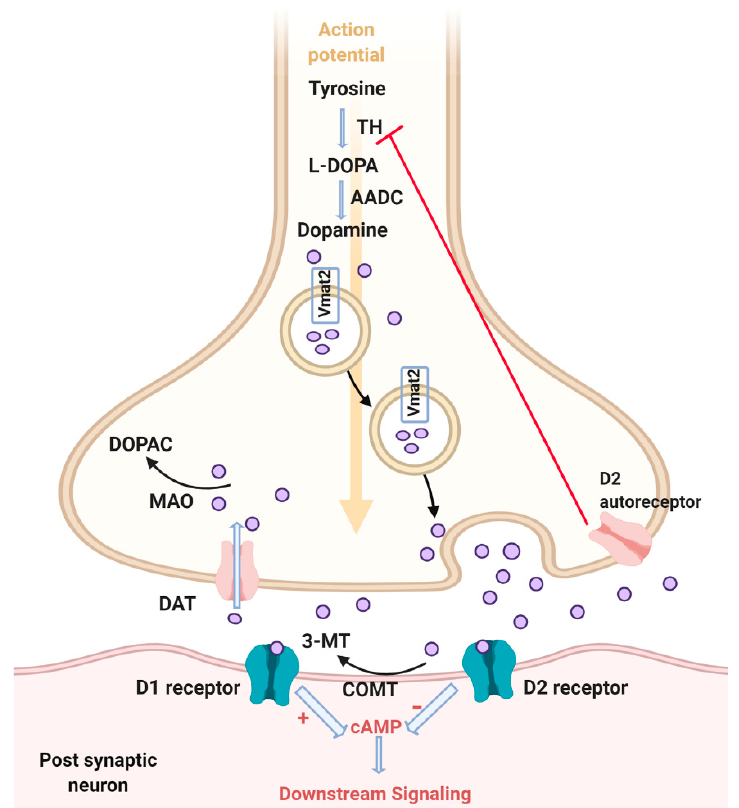
Figure 1. Dopamine signaling pathway. Tyrosine is converted to L-DOPA by the rate limiting step enzyme, tyrosine hydroxylase (TH). Then dopamine is synthesized by action of the aromatic amino acid decarboxylase (AADC). Dopamine is packed in the cytosol via vesicular monoamine transporter 2 (Vmat2). Dopamine is then released from vesicles into the synaptic cleft in response to an action potential. Dopamine can either bind to D1 receptor and activate adenylate cyclase and consequently activate downstream signaling through cAMP, or bind D2 receptor and inhibit adenylate cyclase and downstream signaling. Reuptake of dopamine from the synaptic cleft to the cytosol occurs through the dopamine transporter (DAT). Then dopamine can either be degraded to 3,4-dihydroxyphenylacetic acid (DOPAC) via monoamine oxidase (MAO) or repacked in vesicles via Vmat2. Dopamine can also be degraded in the synaptic cleft via catechol-O-methyltransferase (COMT) to 3 methyltyramine (3MT). Extracellular dopamine can bind to the D2 autoreceptor, which inhibits the synthesis of dopamine. Created with BioRender.com.